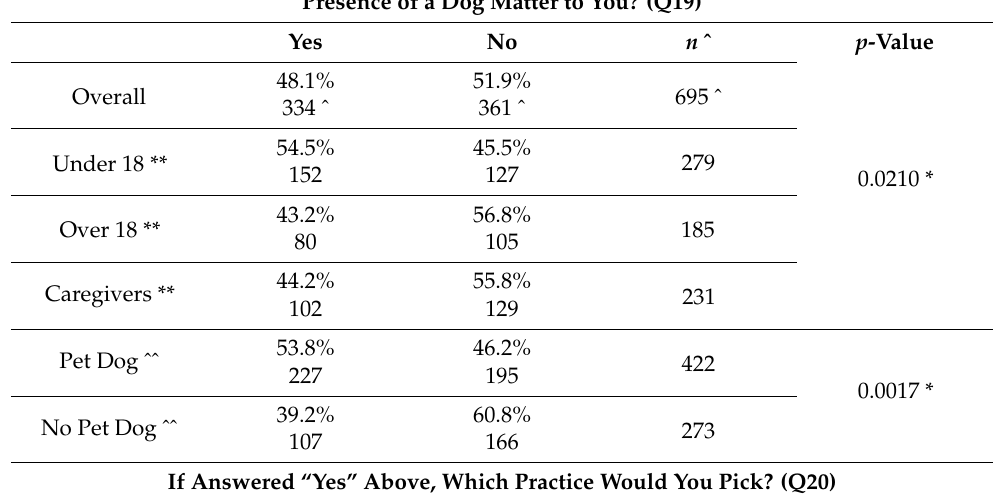
Table 3. The AAA’s impact on patient and caregiver’s orthodontic office selection. If You Were Making a Choice Between Two Similar Orthodontic Practices, Would the